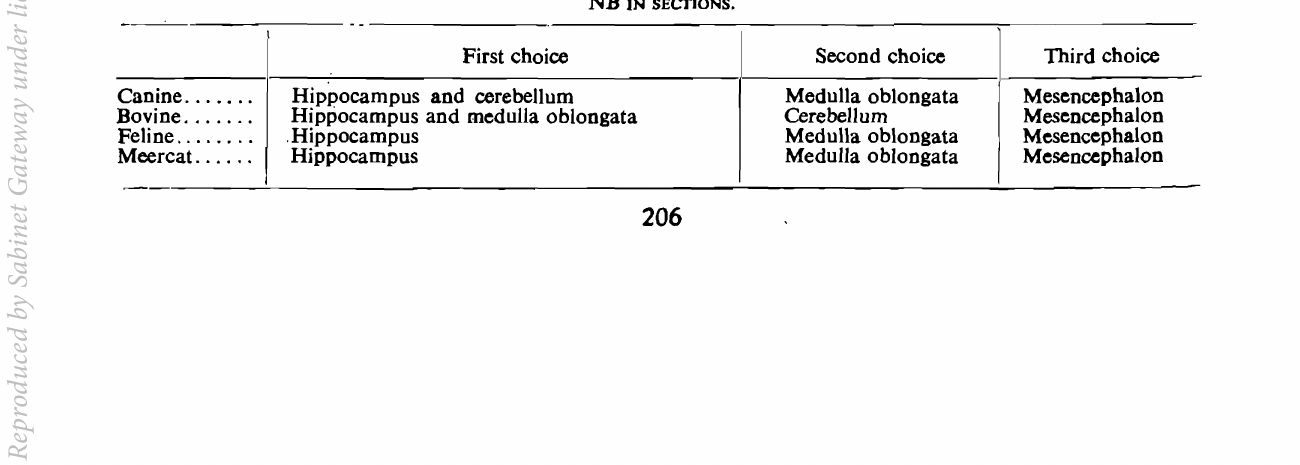
TABLE 4.-THE MOST SUITABLE Of THE FIVE SITES, IN ORDER OF PREFERENCE, fOR THE HISTOLOGICAL DEMONSTRATION OF NB IN SEcnONS. -